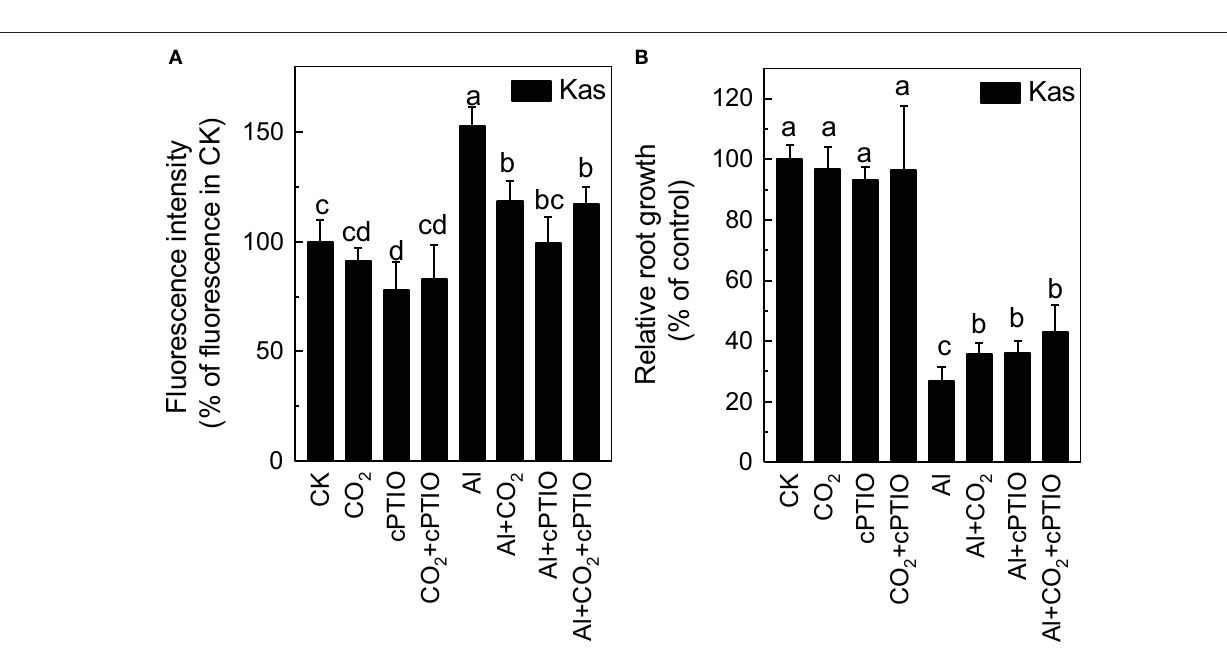
FIGURE 8 | Role of NO in the elevated CO 2 alleviated Al-toxicity in Kas. Three-day-old rice seedlings were treated with a 0.5 mM CaCl 2 solution with or without 50 µ M Al under ambient or elevated CO 2 for 24 h in the presence or absence of c-PTIO for the NO production analysis (A) and root length measurement (B) .